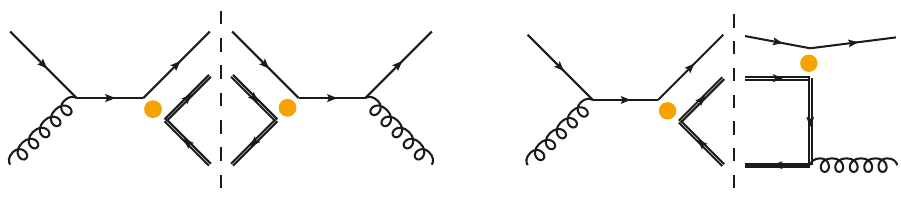
Figure 3 . Operator contributions to the charge asymmetry in t (cid:22) tj production from initial-state radiation (left) and interference of initial- and (cid:12)nal-state radiation (right). Single lines represent light quarks, double lines represent top quarks. Orange dots indicate the insertion of a four-quark operator or of a gluon. The dashed line symbolizes the interference M 1 M (cid:3) amplitudes M 1 and M (cid:3) to its left and right 2